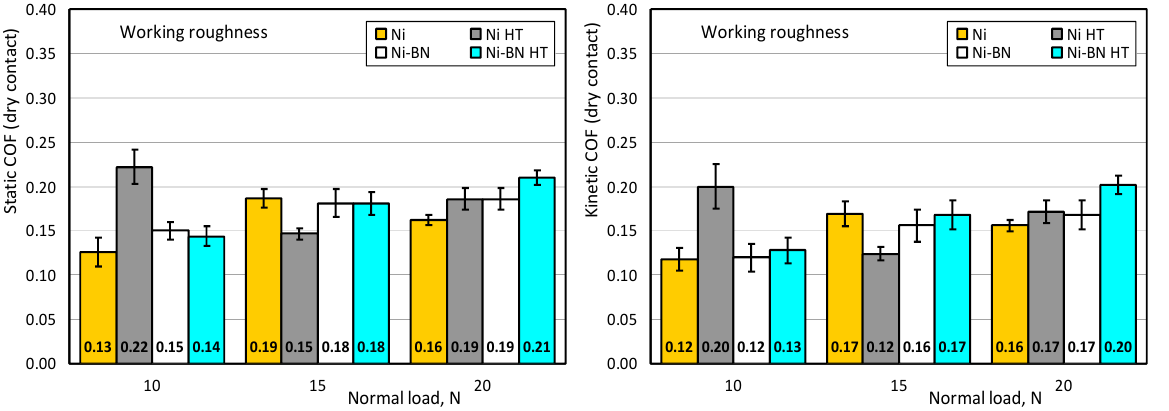
Figure 8. Static and kinetic coefficient of friction (COF) values and appropriate standard deviations of coatings with working roughness, tested at different normal loads in dry contact conditions. Comparing the values of both static and kinetic COF obtained for the same coating with different surface conditions (initial and working roughness), it could be noticed that the values are much lower for the working roughness conditions (0.173 vs. 0.271 for the static COF and 0.157 vs. 0.247 for the kinetic COF). This is in line with the results obtained for various roughness of surfaces machined with different machining processes, which show that the static COF value is higher if contact surfaces have higher roughness parameters [23]. In this study, the average surface roughness of the as-deposited coatings (initial roughness) was 0.413 μm (Table 3), which is relatively high. In addition to this, the bronze